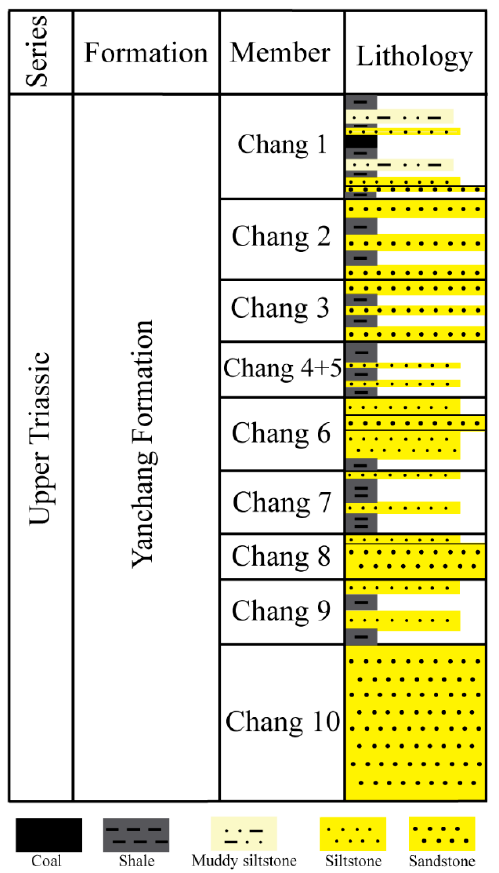
Figure 2. Generalized stratigraphy of the Triassic Yanchang Formation in the Ordos Basin. The thickness of different members is not to